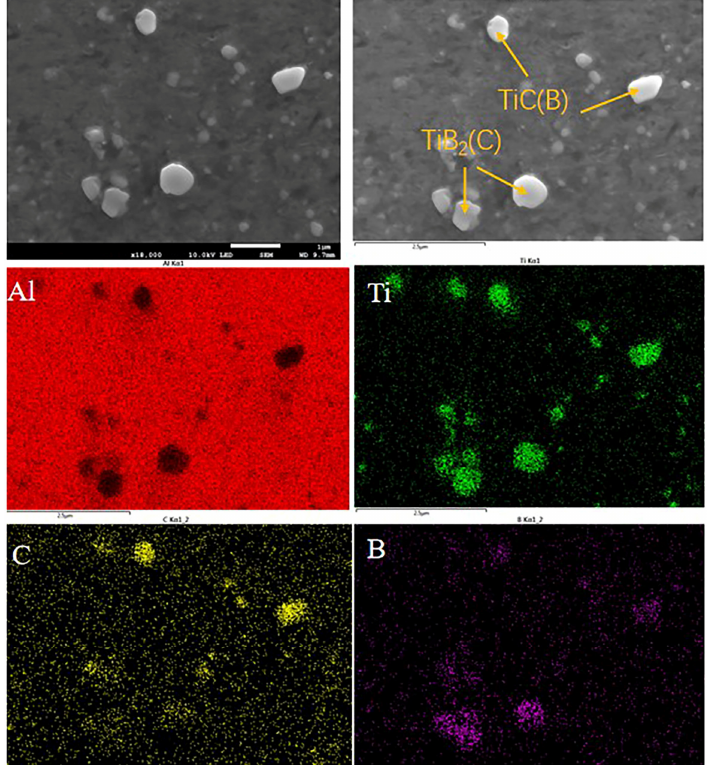
Figure 3. Element mapping of an area in the Al-5Ti-0.25C-0.25B alloy.